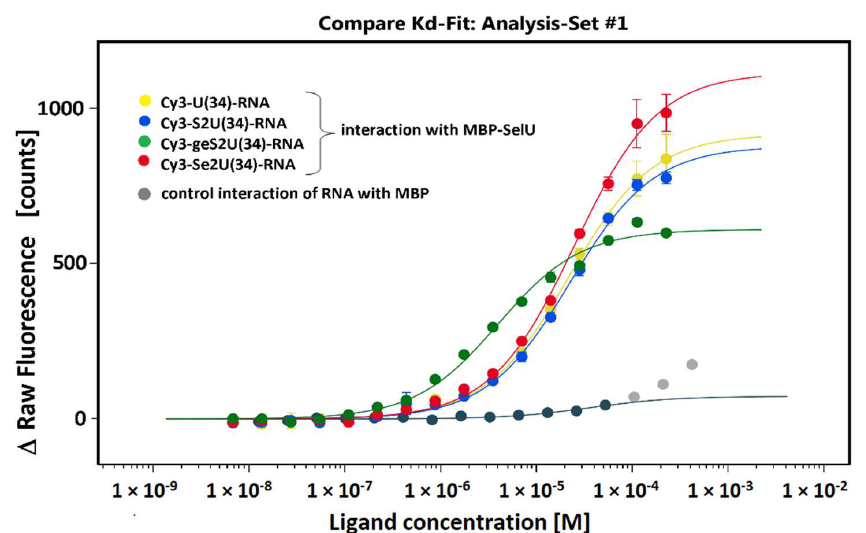
Figure 3. Normalized ∆ Raw Fluorescence changes in Cy3-labeled ASL–RNAs plotted as a function of MBP–SelU ligand concentration. Interactions between the Cy3-RNA and the MBP protein were the negative control for the performed experiments. The data shown are the averages of three replicates for all pairs of interacting molecules: MBP–SelU:Cy3-U(34)–RNA, MBP–SelU:Cy3-S2U(34)–RNA, MBP–SelU:Cy3-geS2U(34)–RNA, and MBP–SelU:Cy3-Se2U(34)–RNA. The error bars represent the standard deviation (± Std).